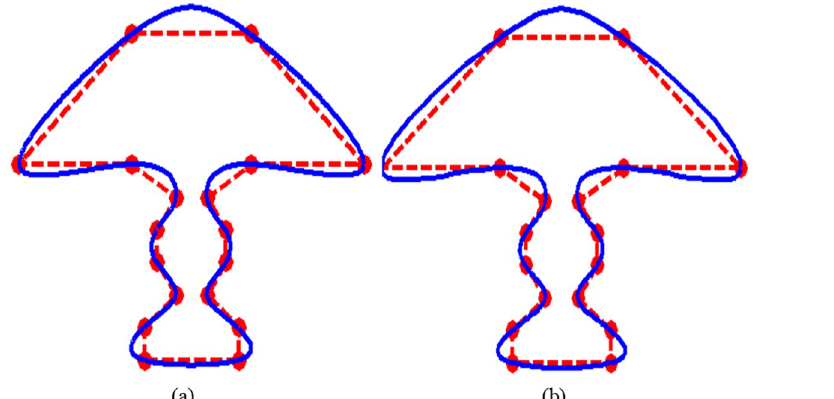
Fig 9. Data of a lamp is interpolated: (a) by CPS; (b) by QTS.